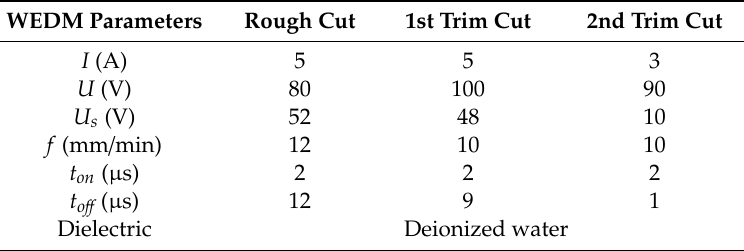
Table 2. WEDM parameters for preparing the surface.